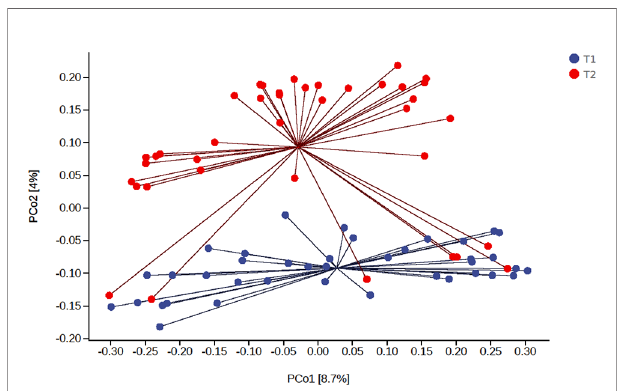
FIGURE 2 | The principal coordinate analysis of the difference of the tongue coating microbiota before and after sleep (the percentage in the brackets of the coordinate axis represents the proportion of sample difference data (distance matrix) that can be explained by the corresponding